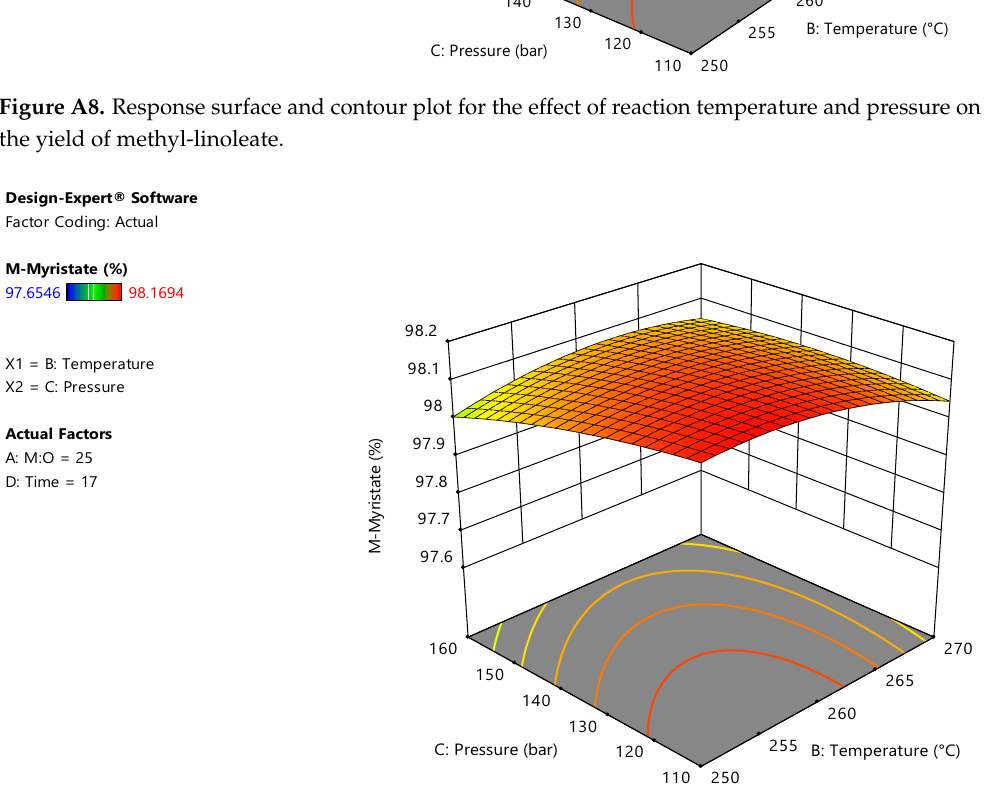
Figure A9. Response surface and contour plot for the effect of reaction temperature and pressure on the yield of methyl-myristate.